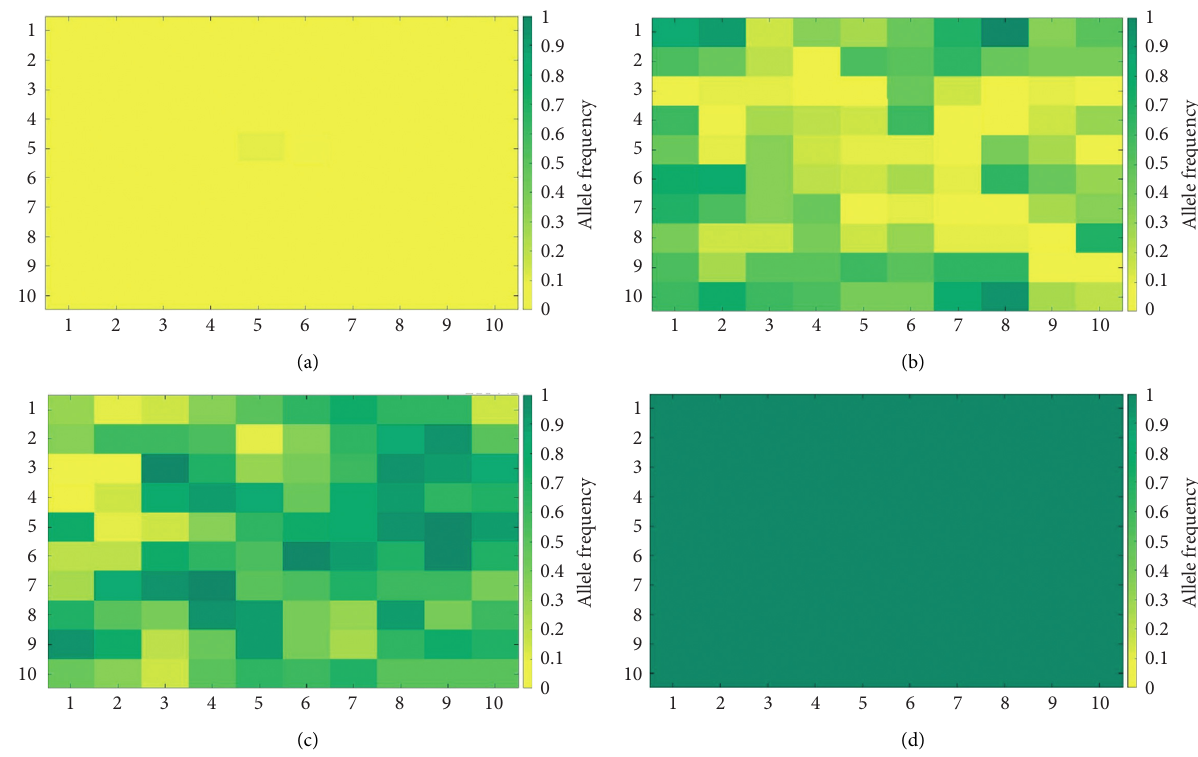
Figure 6: Evolution of the frequency of the focal allele A distributed over a spatial grid. The allele frequency increases by genetic drift and it 1 spreads in the population via migration till getting activated at t ′ � 1000 generations, resulting in subsequent fixation of the allele. (a) t � 0. (b) t � 500. (c) t � 1000. (d) End of the solution.